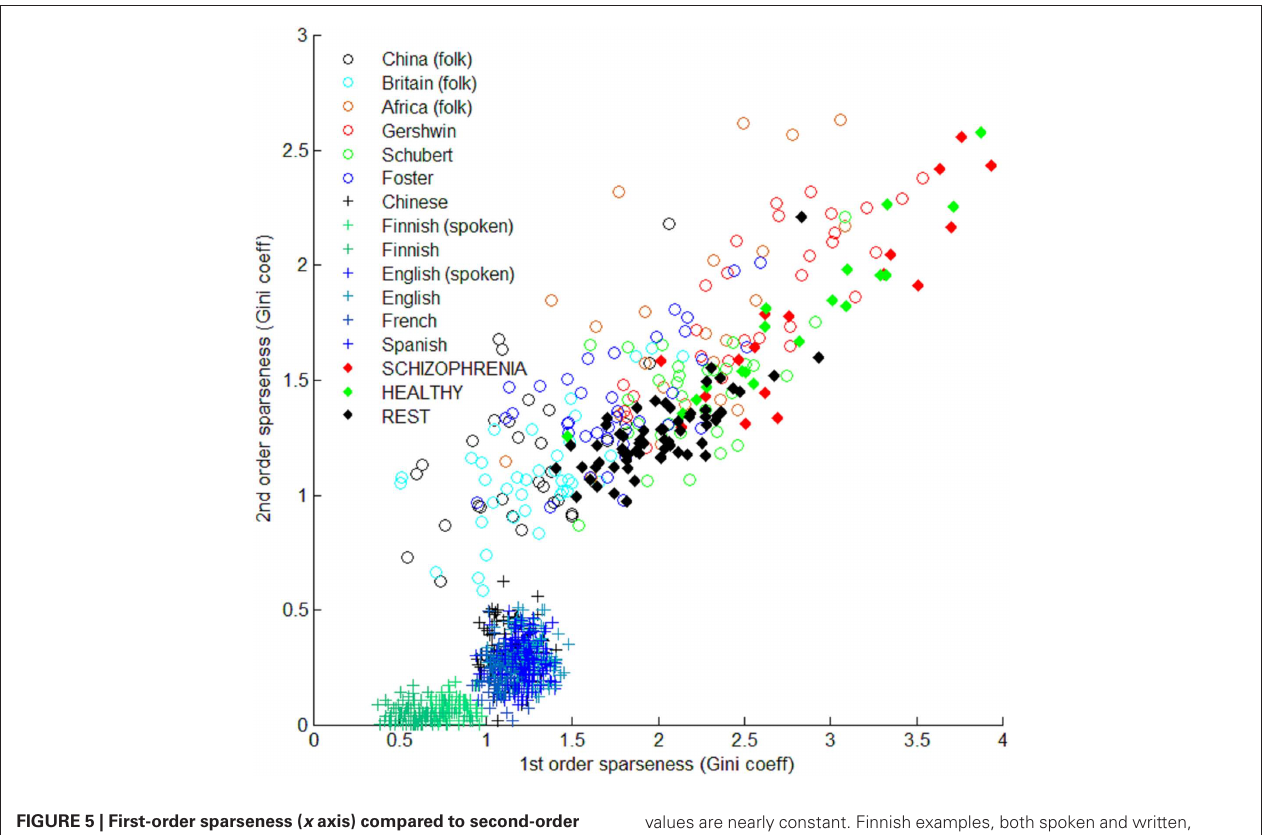
values are nearly constant. Finnish examples, both spoken and written, are outliers, perhaps due to the complex grammar of the language. In music and brain data, first and second-order sparseness varies across melodies and subjects, and the two orders of sparseness seem to be